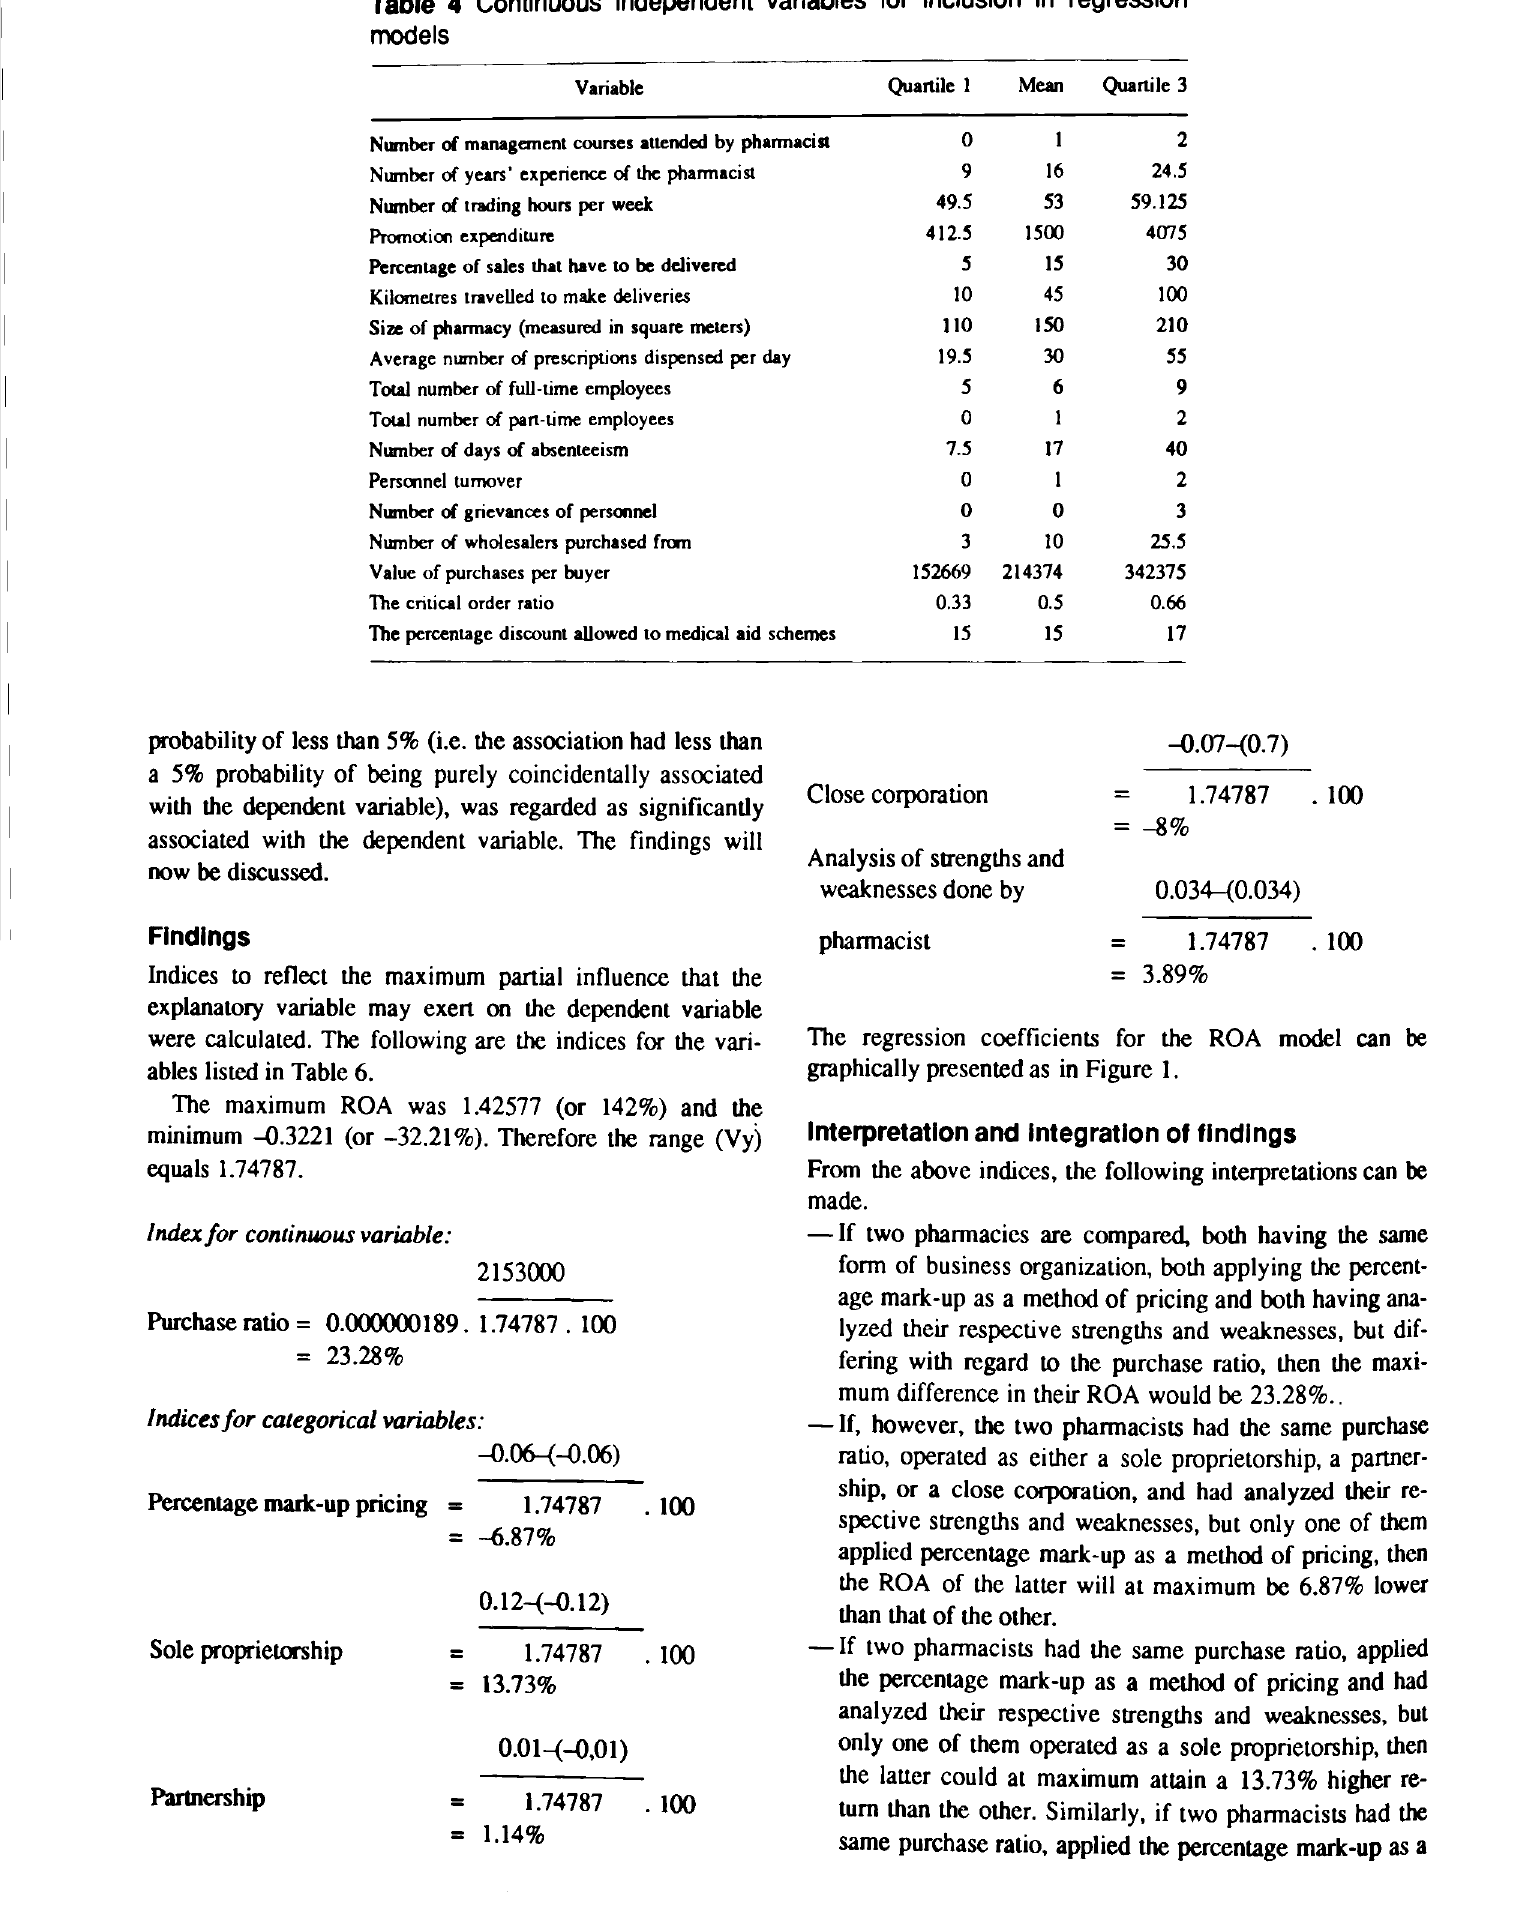
Table 4 Continuous independent variables for inclusion in